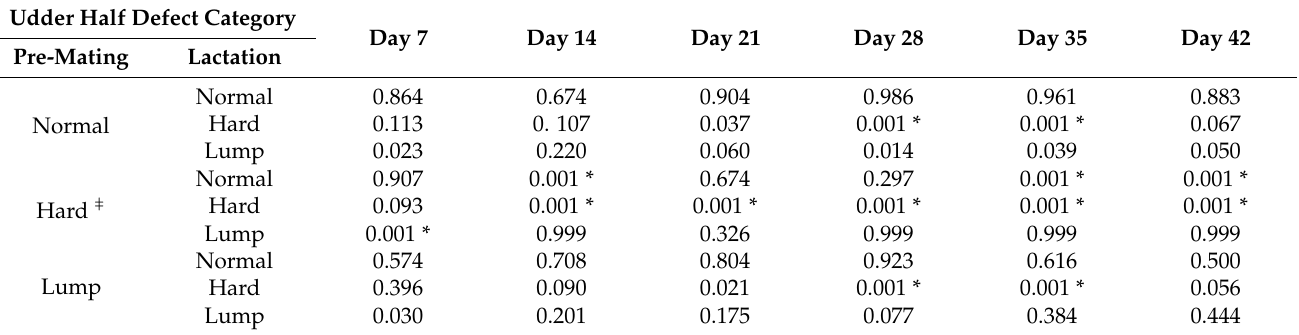
Table 5. Predicted probability (Pp) of udder half defects change over time from Day 7 to 42 of lactation based on pre-mating udder half defect category in 92 udder halves (from 46 non-dairy Romney ewes; Study